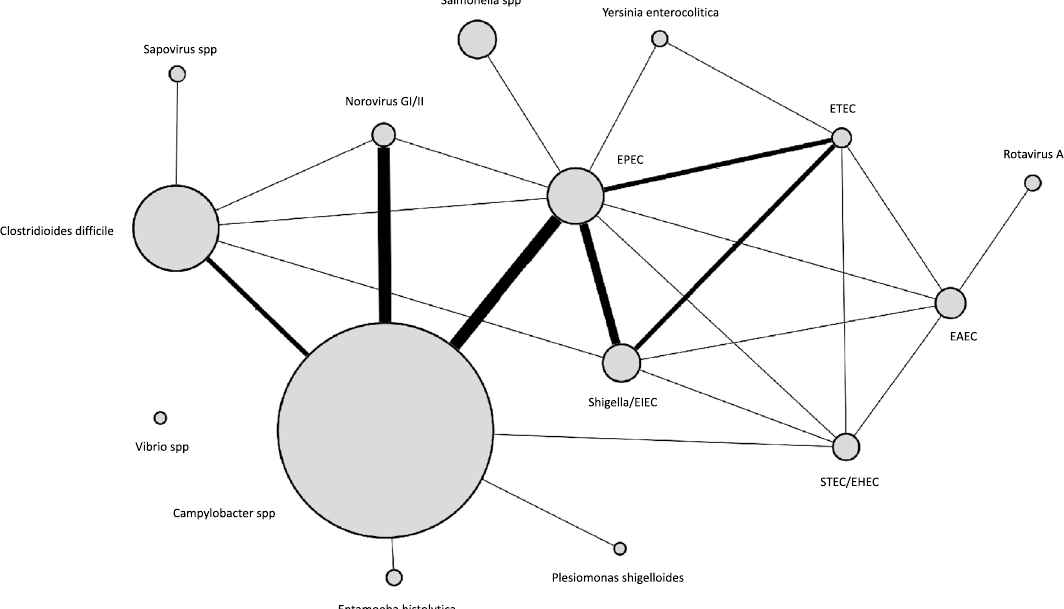
Figure 2. Network representation of positive targets for FilmArray GI panel. Fecal samples of patients with CT-proven acute colitis were screened using FilmArray GI panel. Every node represents a target of FilmArray GI panel, and every edge indicates whether or not this target was found in co-localization with another target in the same fecal sample. The weight of the edges indicates the number of co-localisations observed (ranging from 1 to 4), whereas the surface of the nodes indicates the prevalence of every target in the cohort. Positive FilmArray Diagnosis Patients, n (%) Histology Patients, n (%) assay, n